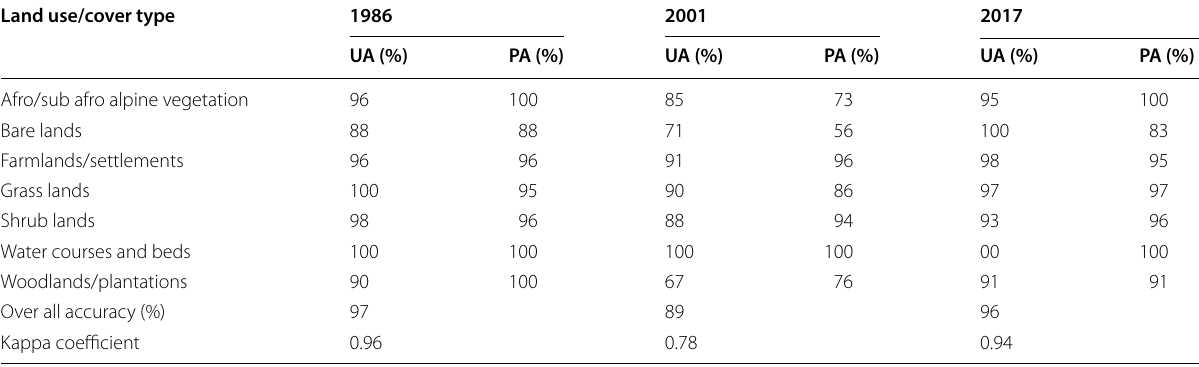
Table 5 Classification accuracy assessments of 1986, 2001 and 2017 images using error